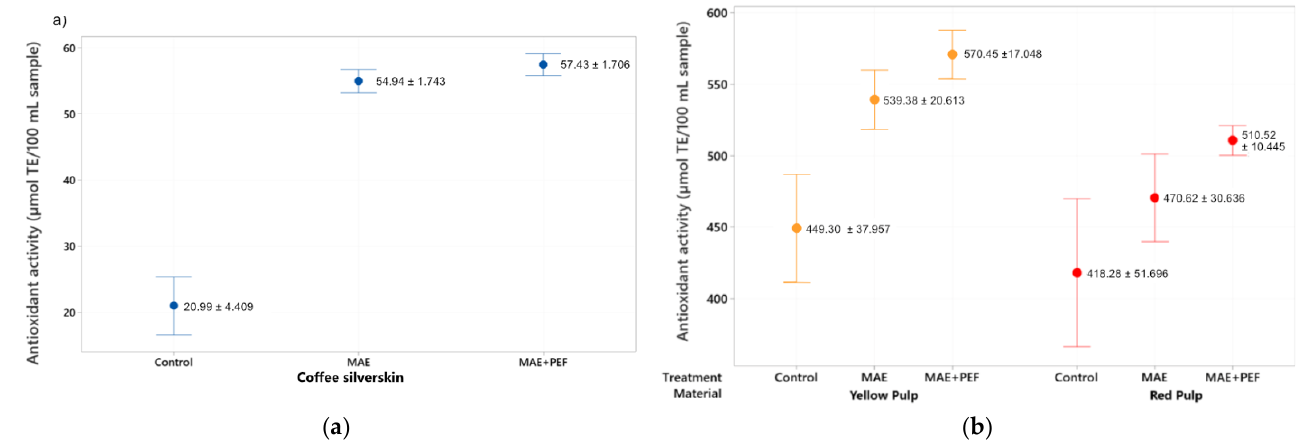
Figure 3. DPPH antioxidant assay of coffee agro-waste extracts. Values are represented as mean ± standard deviation ( n = 3). TE: Trolox equivalents. ( a ) Assay results for parchment waste. ( b ) Assay results for yellow and red pulp waste. MAE: Microwave assisted extraction; PEF: Pulsed Electric Field pretreatment.